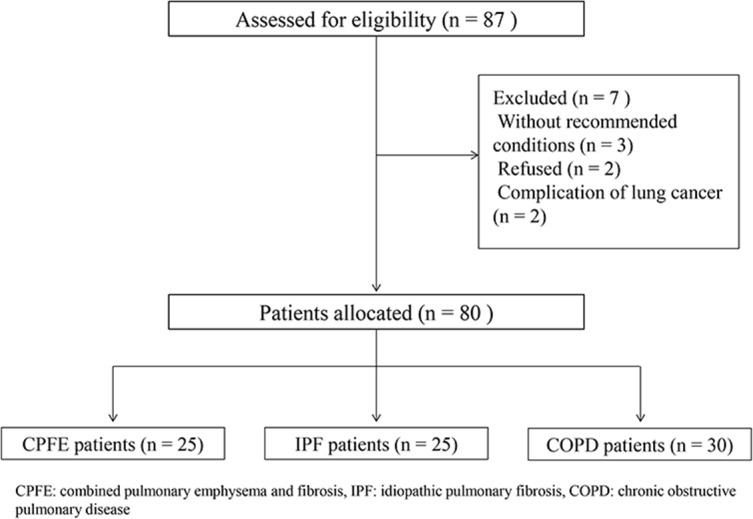
Study flow chart.